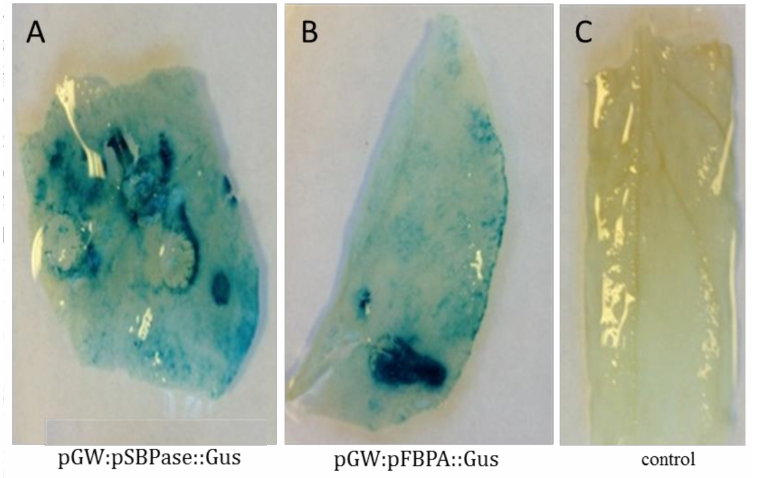
Figure 2. Histochemical GUS assay of agroinfiltrated N. benthamiana leaves. The transient expression assays were performed on four- to five-week old N. benthamiana leaves, incubated at 24 ◦ C in 16 h/8 h light/dark for 72 h after infiltration prior to GUS staining: ( A ) gus expression driven by the SBPase promoter; ( B ) gus expression driven by the FBPA promoter; and ( C ) control (wild type: non-infiltrated